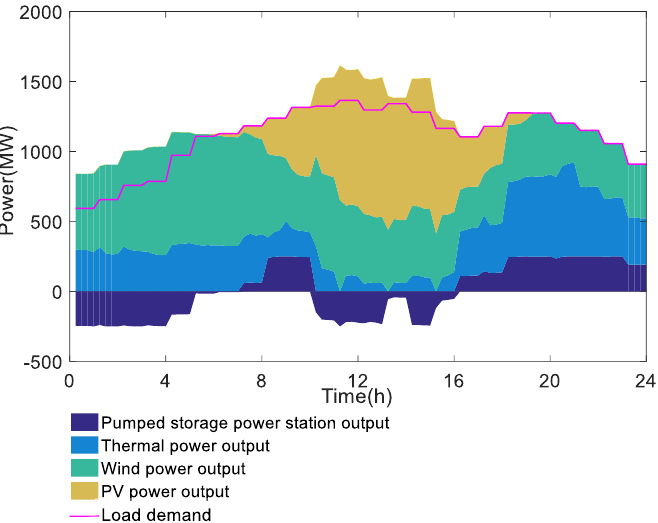
Figure 10. Revised actual output and load demand curves of each